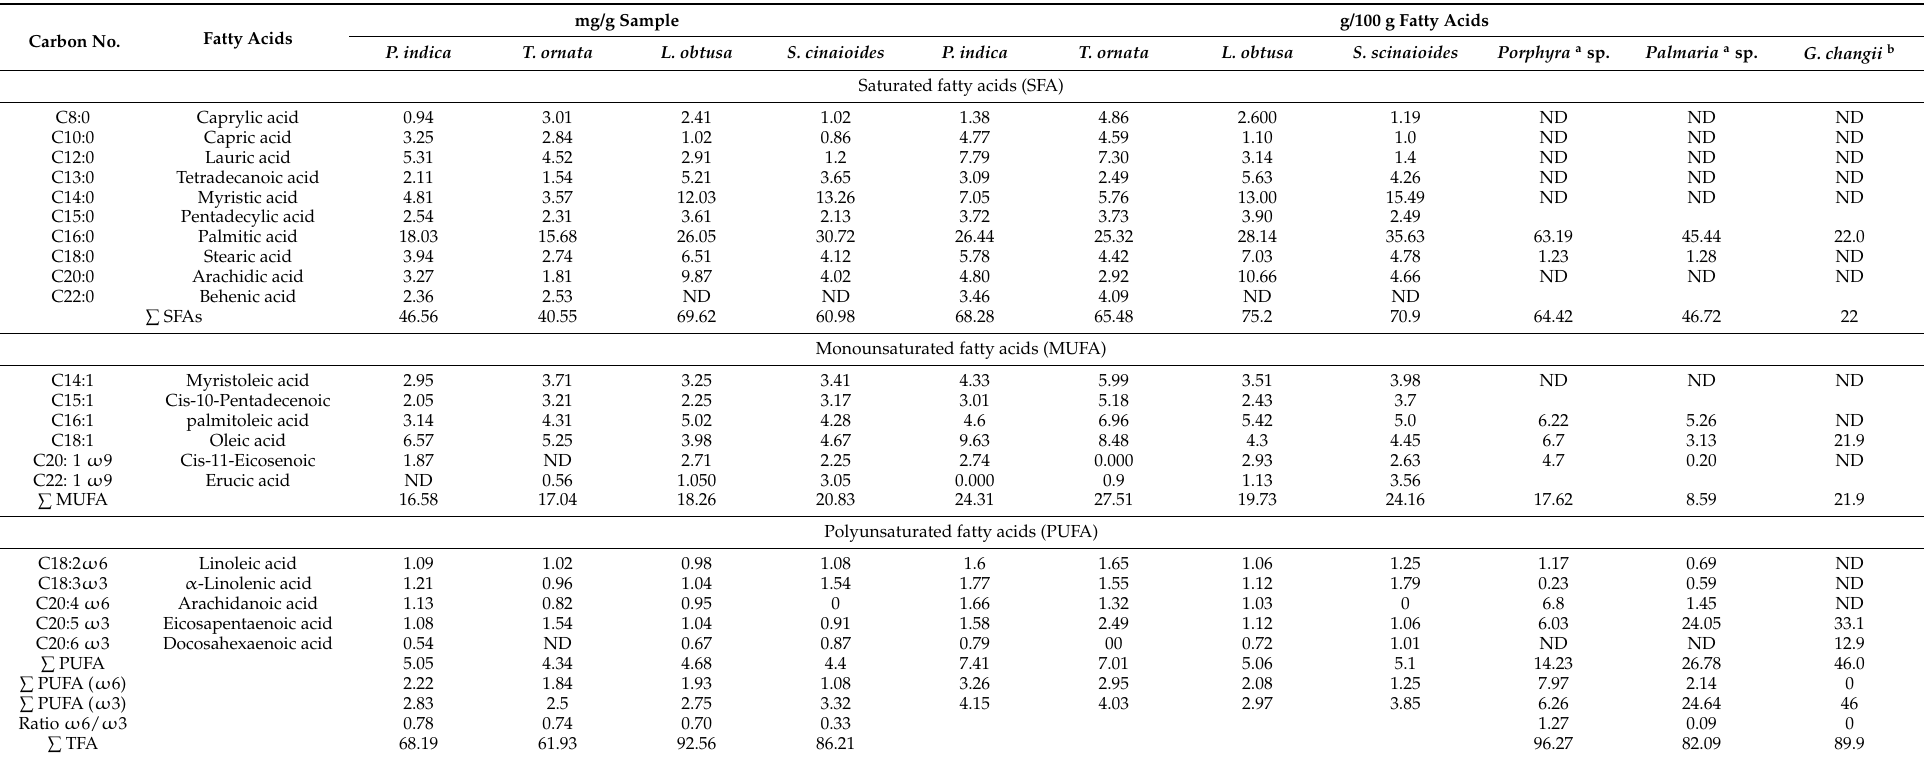
Table 3. Fatty acid compositions of the studied Phaeophyceae and Rhodophyceae species (mg/g sample) and profiles (g/100 g fatty acids). Carbon